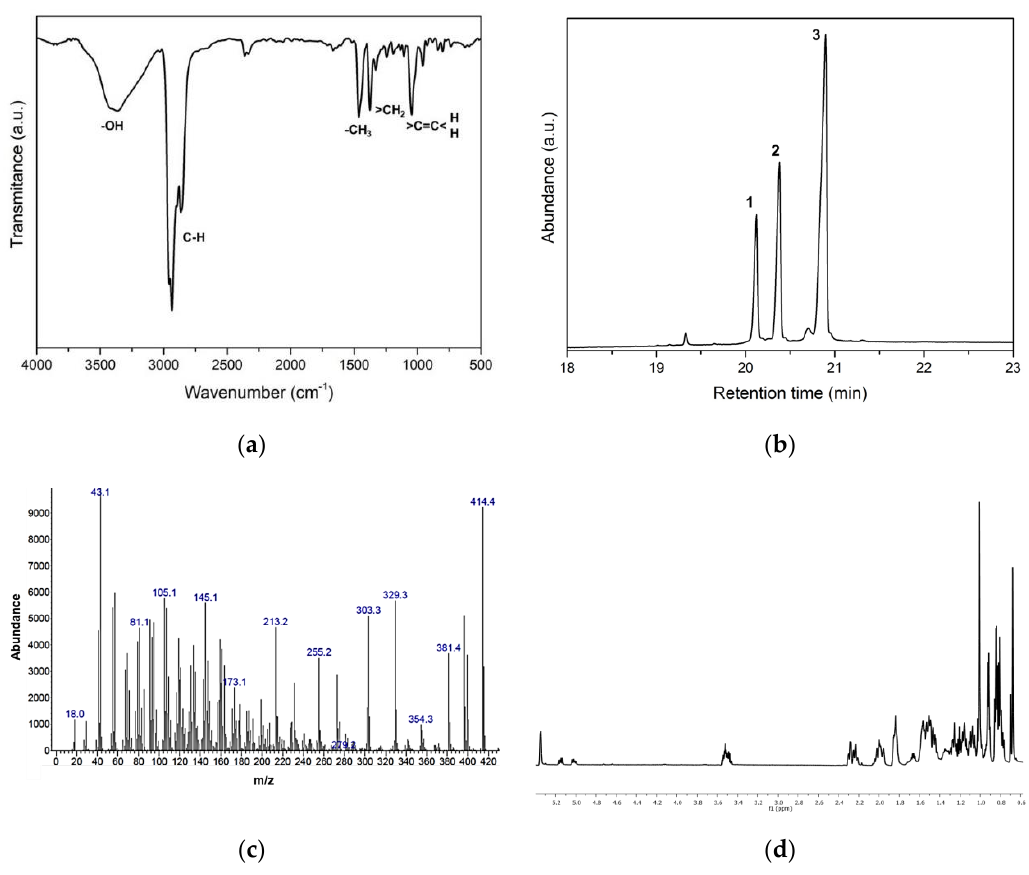
Figure 4. Characterization of anti-HA compounds in C4: ( a ) FTIR spectra of C4 showed absorption bands for hydroxyl groups at 3400 cm − 1 as well as the tensile vibration of C–H sp3 bonds around 2900 cm − 1 . The bands found in the fingerprint region could be related to the vibrational modes of methyl, methylene and C=C double bonds. ( b ) GC-MS chromatogram of C4 showing three main peaks at retention times of 20.10 min, 20.50 min and 20.90 min that were characterized as campesterol (peak 1), stigmasterol (peak 2) and β -sitosterol (peak 3), with a similar molecular mass from m / z 414. ( c ) Chromatogram of the mass fragmentation (GC-MS) of C4, with a fragment at m / z 396, which corresponds to the OH group in position 3; an m / z 255 fragment, formed by the loss of the side chain attached to the sterane; and the fragments resulting from the loss of the side chain by the original sterane without water loss (273 m / z ) and with the subsequent loss of 18 units due to the water molecule (OH group of position 3). ( d ) 1 HNMR spectrum (CDCl 3 , 600 MHz) of the C4 fraction corresponding to a mixture of steroidal compounds. Table 2. Cytotoxic and antiviral activity of C4, β -sitosterol, stigmasterol and